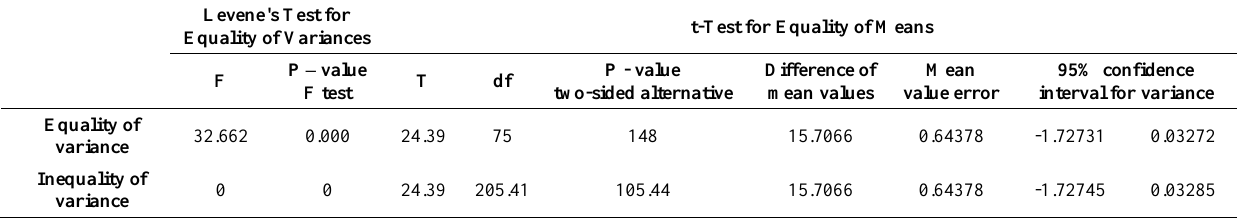
Table 3. Two-sample t-test for hypothesis H1